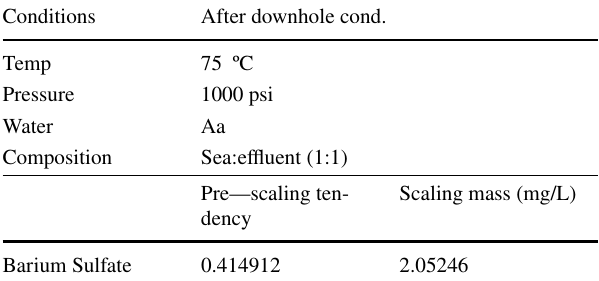
Table 3 Scale prediction for the selected water mix ratio after down- hole